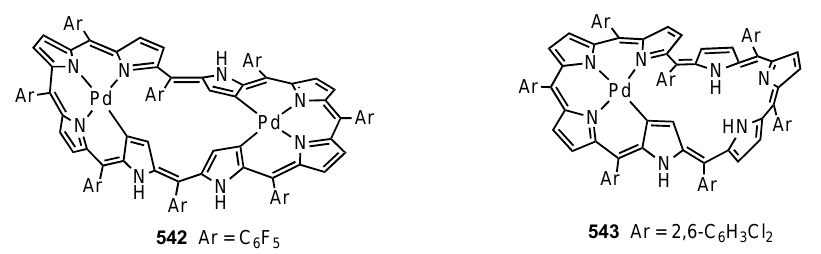
Figure 15. Metallocenoporphyrins. Another intriguing class of porphyrin-like structures have been prepared from 21,23- ditelluraporphyrins 547 (Scheme 84). Reaction of 547 with palladium(II) acetate and